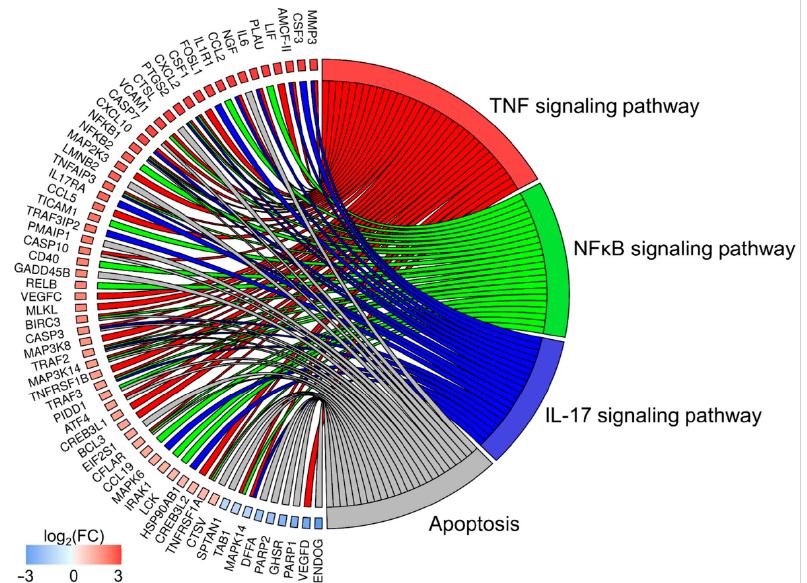
Figure 4. Circos plot represents four significantly enriched Kyoto Encyclopedia of Genes and Genomes (KEGG) pathways associated with differentially expressed genes (DEGs) engaged in deep vein thrombosis (DVT). Gene symbols with logarithmic values (blue-red scale) of fold change (logFC) are located on the left side of circos. Four color links merge genes with KEGG annotations (TNF, NF- κ B, IL-17 and apoptosis signaling pathways) on the right